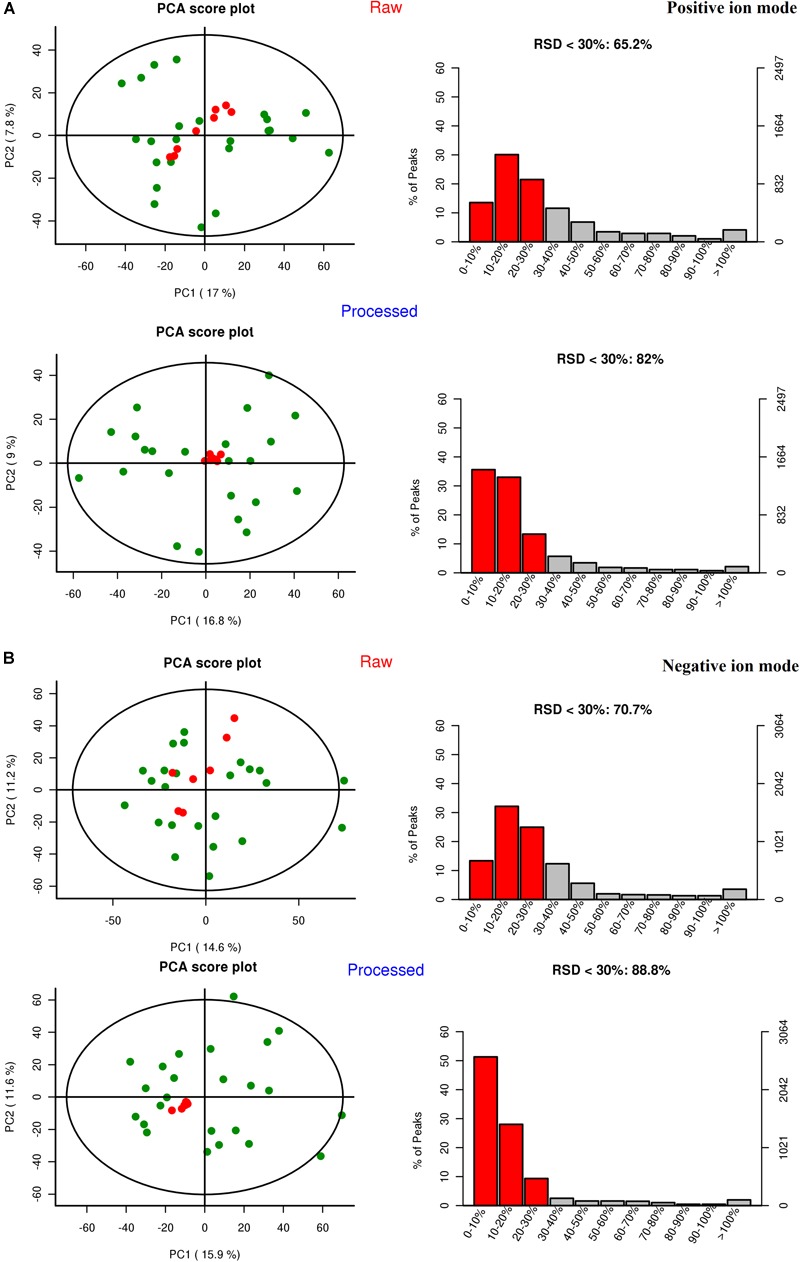
The results of the quality assurance (QA). (A) At positive ion mode. (B) At negative ion mode.